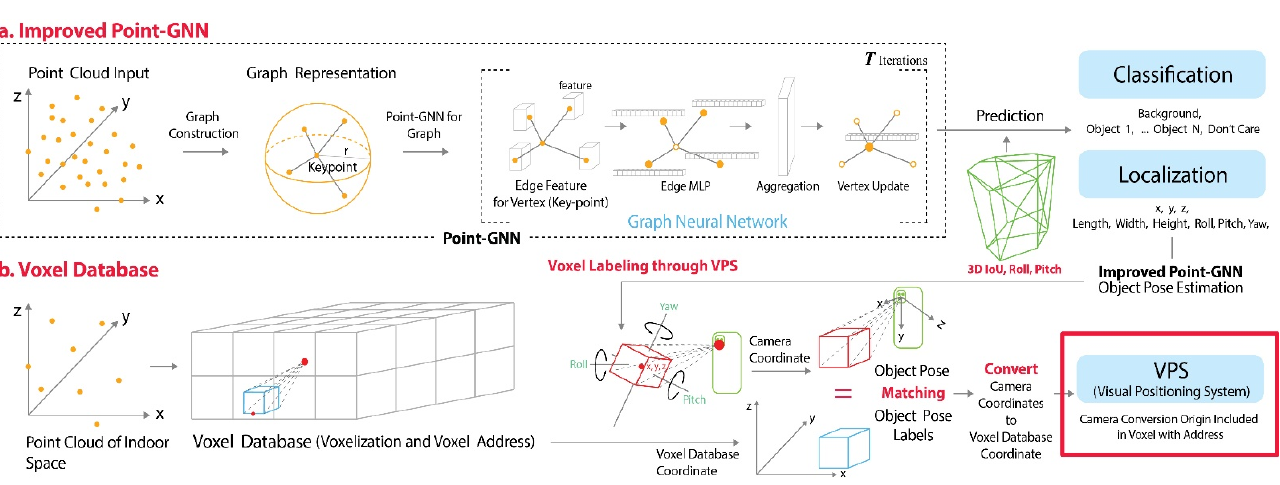
5 of 16 Table 2. Comparison of localization error with existing CNN models on the 7-Scenes dataset. CNN models